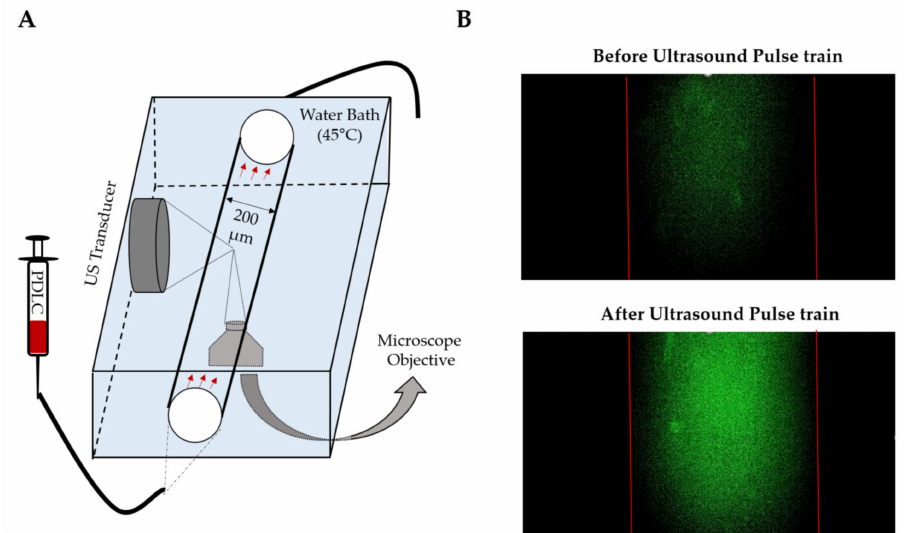
Figure 7. Calcein release from decafluorobutane (DFB) PDLCs inside of a capillary after a single pulse train (300 cycles,1.85MPa, 1.1 MHz) ( A ) Schematic setup for visualizing calcein release in a capillary tube. ( B ) Fluorescent images of PDLCs before and after US exposure. An instant increase of fluorescence in the green channel shows the instant release of calcein inside of the capillary tube. This experiment was repeated on three independent